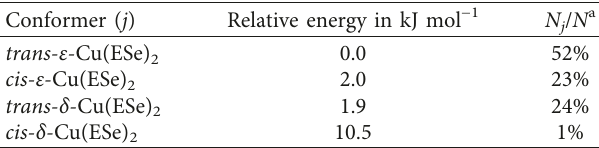
Table 2: The relative energies and populations of the Cu(II)(ESe) complexes